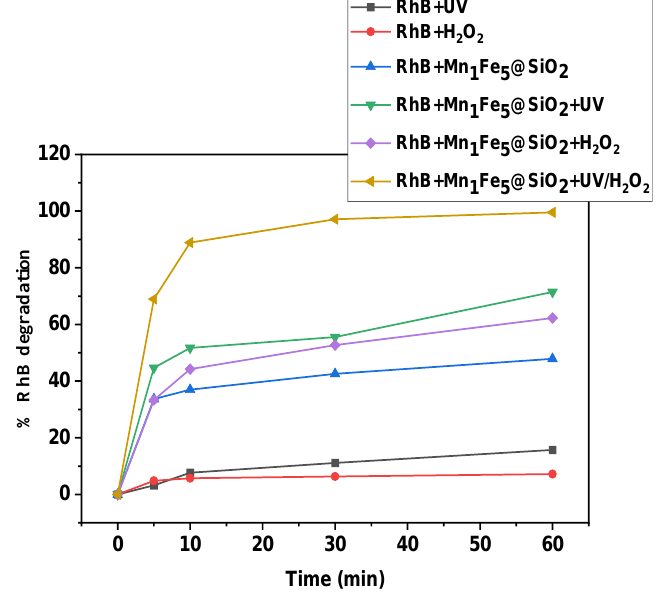
Figure 12. Degradation performance of Mn 1 Fe 5 @SiO 2 in different systems in optimized condition [RhB] = 50 mg L – 1 , [Catalyst dosage] = 1 g L – 1 , [H 2 O 2 ] = 75 mmol L – 1 , [UV intensity] = 32 W, [pH] = Neutral. Table 2. Comparison of the performance of the synthesized nanomaterial with other studies. Adsorbent/Catalyst Pollutant Experimental Condition Removal